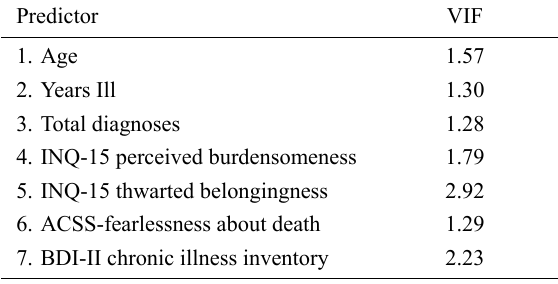
Table 5. Variance inflation factors